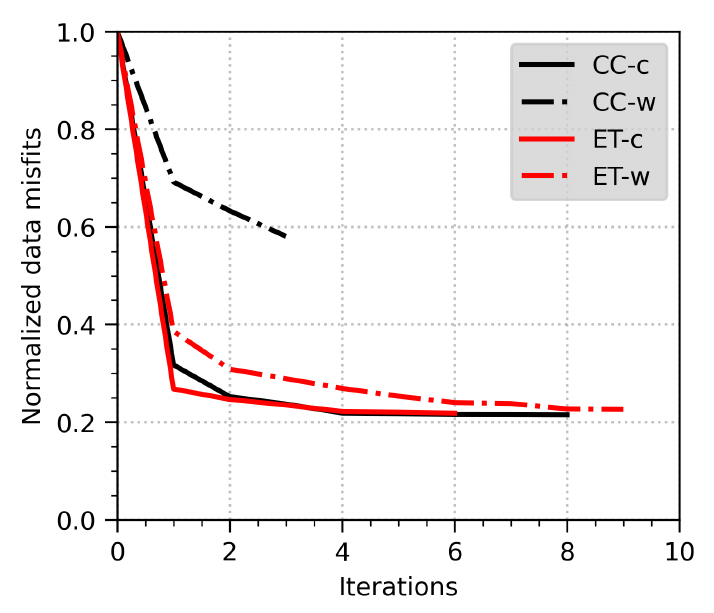
Figure 15. Reductions of the normalized data misfits for travel-time inversion of early arrivals. The solid-black and dash-dotted-black lines indicate traditional CC objective function data misfits with correct and wrong source wavelets. The solid-red and dash-dotted-red lines indicate the ET objective function data misfits with correct and wrong source wavelets.